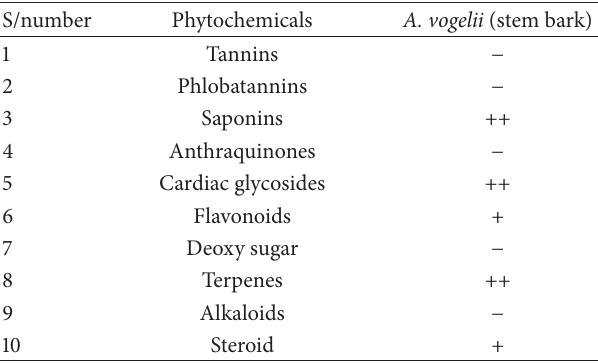
Table 2: Acute toxicity (LD ) of A. vogelii after 72 hours. 50 Group mice